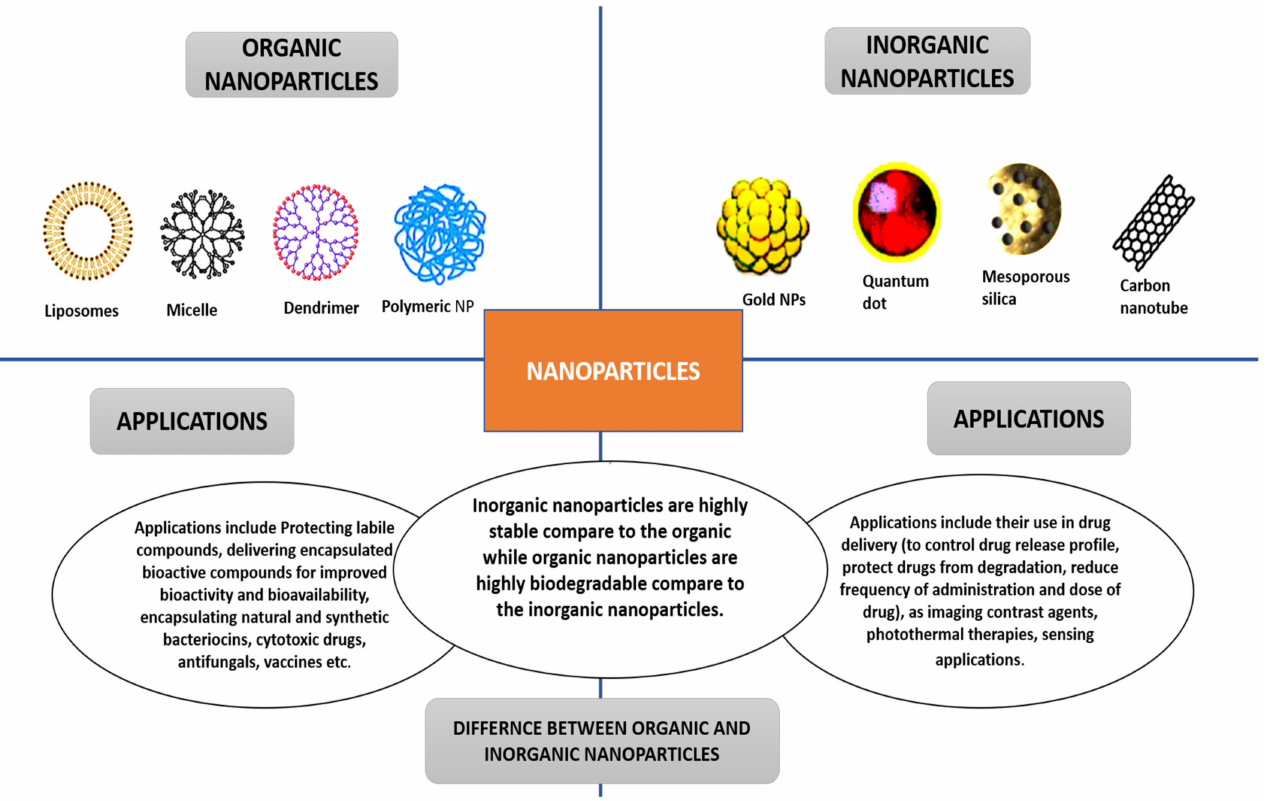
Figure 2. Nanoparticles’ classifications, applications, and